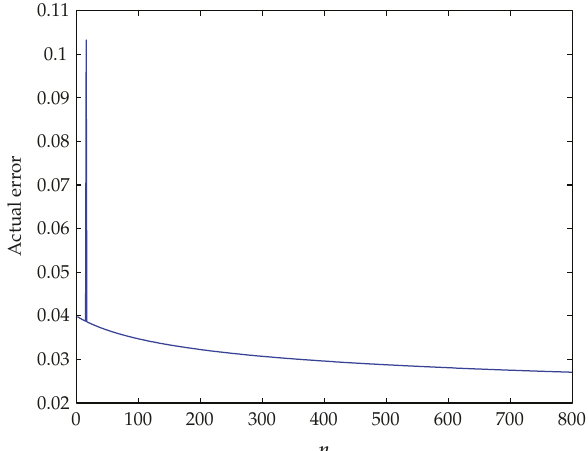
Figure 5: T he actual error, Δ n , for r n (cid:4) 1 / (cid:5) n (cid:2) log n (cid:3) 1 / 2 (cid:2) log log n (cid:3)(cid:2) log log log n (cid:3)(cid:6) and (cid:2) x,y (cid:3) (cid:4) (cid:2) 0 , 0 (cid:3) .